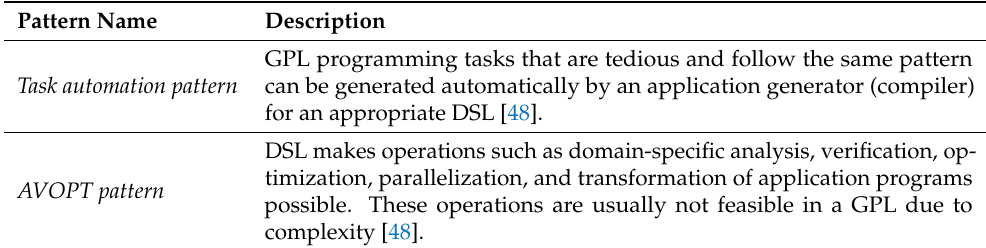
Table 6. Decision patterns used during the decision phase.